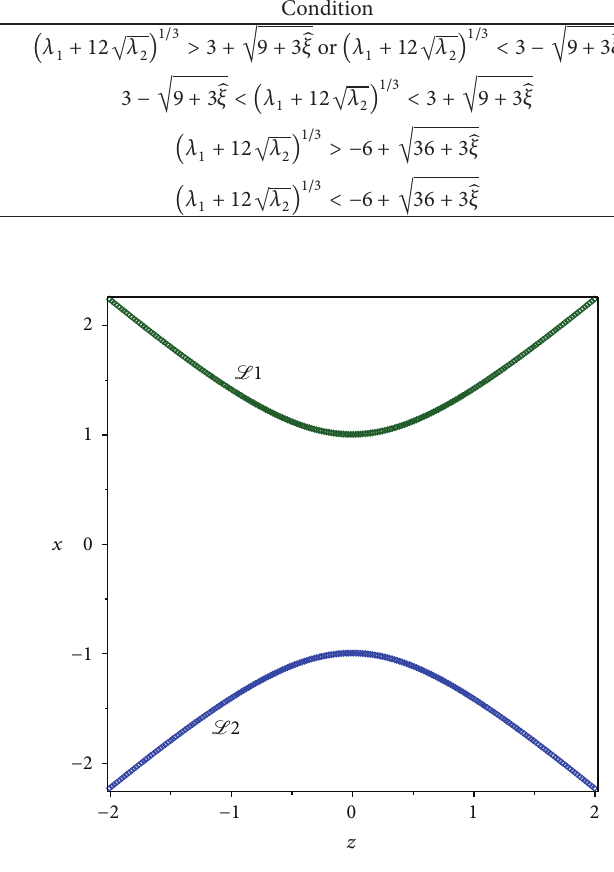
Figure 1: The projection of the phase space evolution on the 𝑥 − Figure 2: The critical lines L 1 and L 2 on the phase plane 𝑥 − 𝑧 𝑢 plane, for the tachyonic teleparallel dark energy model with 𝜉 = −0.001 . This figure is plotted for the case with 𝑦 = 0 . With these values in the parameter space, this figure shows that points with 𝑥 𝑐 = ±√2/2 ≈ 0.707 and arbitrary 𝑢 𝑐 can be attractors of the model.